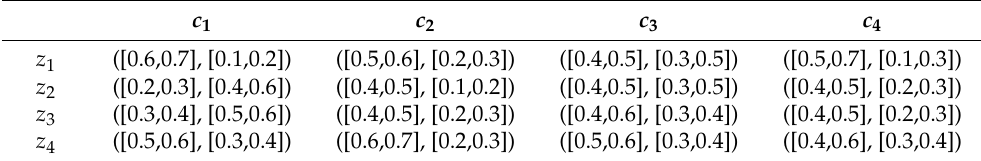
Table 1. The I-VIF decision matrix.